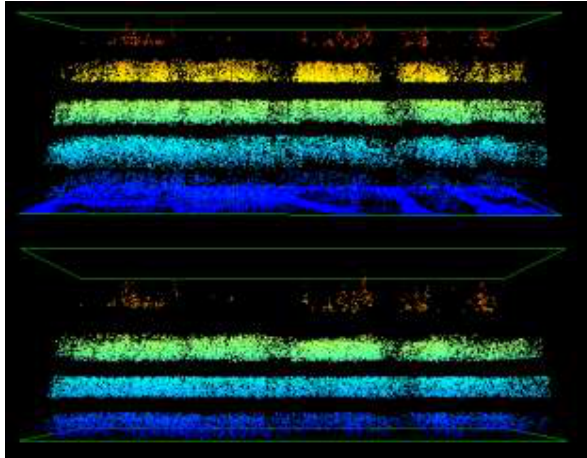
Figure 3. The clustering of points at 10% of maximum height or